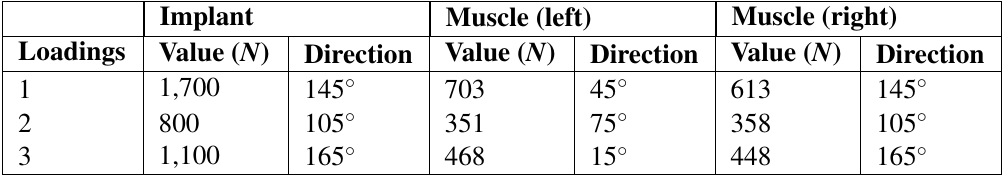
Fig. 6 Bone loadings with a pin. (a)First case; (b) Second case. Table 3 Loading condition for the second case.